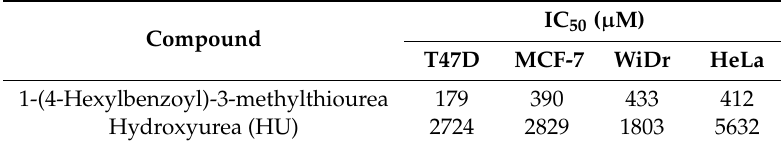
Table 1. IC 50 in vitro cytotoxicity of the tested compounds against HeLa cell line.